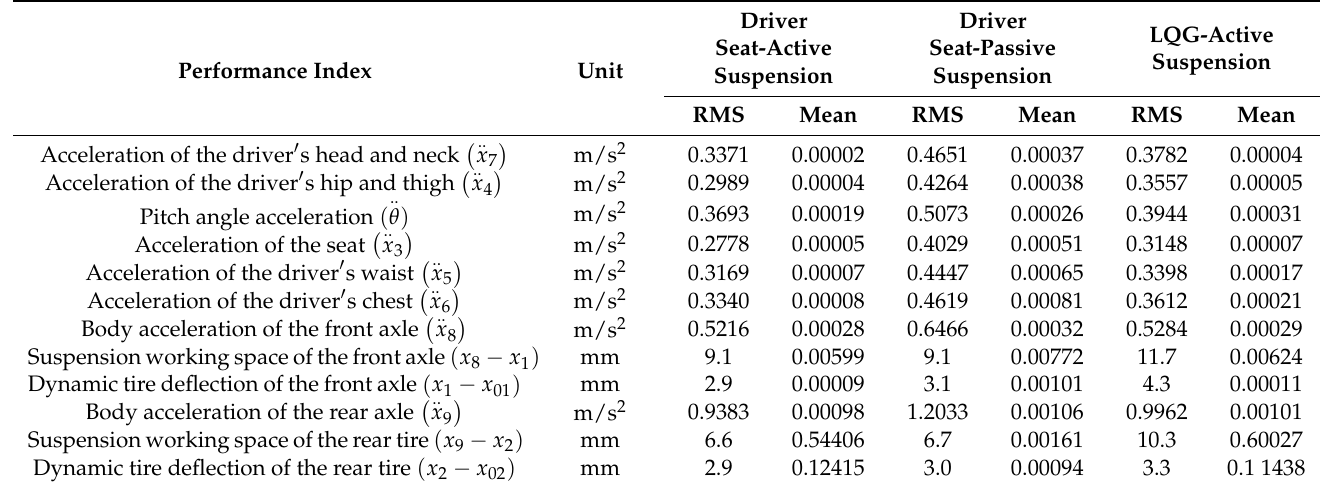
Table 4. Comparison of root mean square values of suspension performance